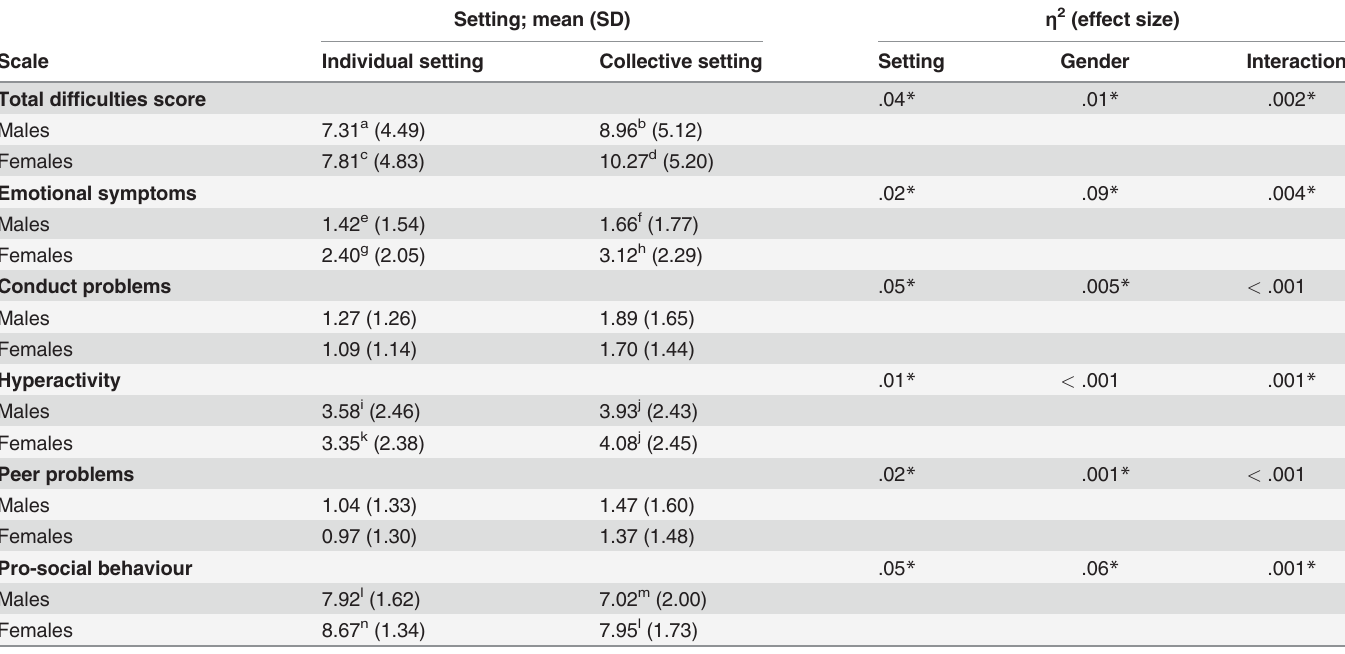
Table 4. Comparisons for SDQ total difficulties and subscales mean scores for each setting and